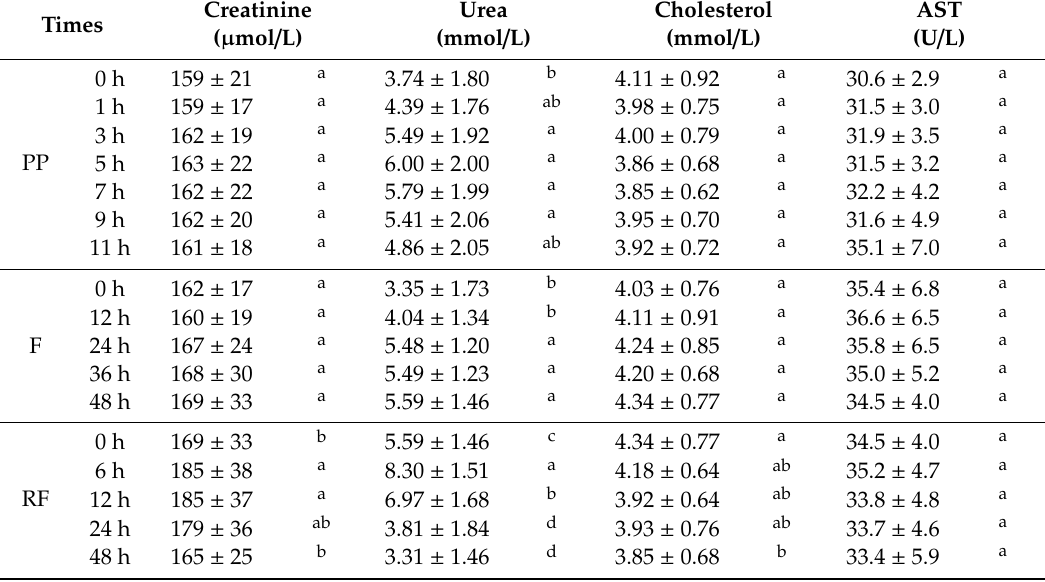
Table 3. Mean values and standard deviations of serum creatinine, urea, cholesterol, and aspartate aminotransferase (AST) activity of cattle in the postprandial periods (PP), fasting (F), and re-feeding (RF). Creatinine Urea Cholesterol AST Times